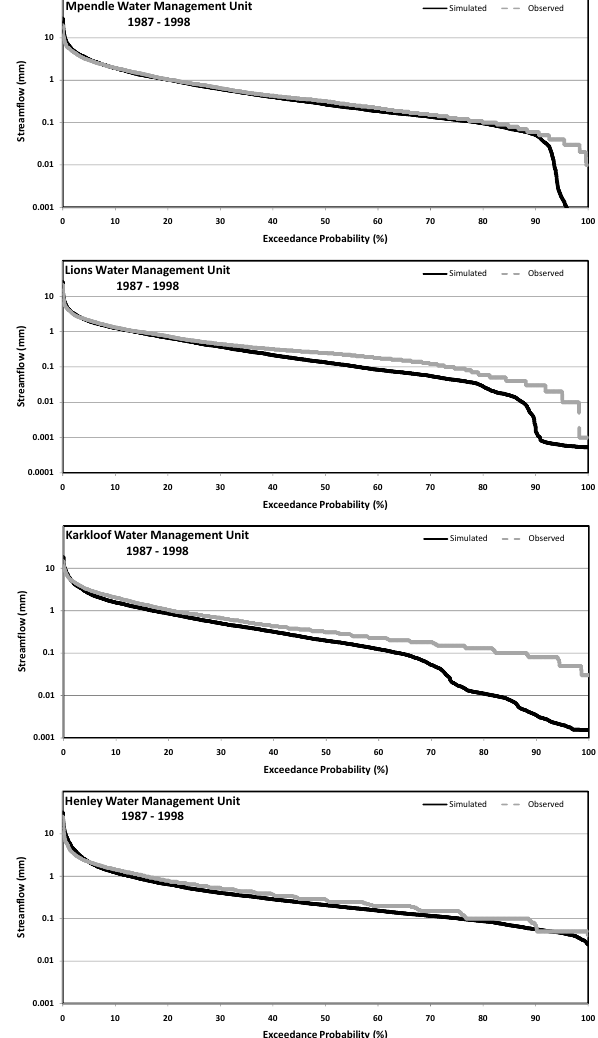
Fig. 8. Comparison of flow duration curves of daily simulated and observed streamflows for (from top to bottom) the Mpendle WMU, Lions River WMU, Karkloof WMU and the Henley WMU of the Mgeni